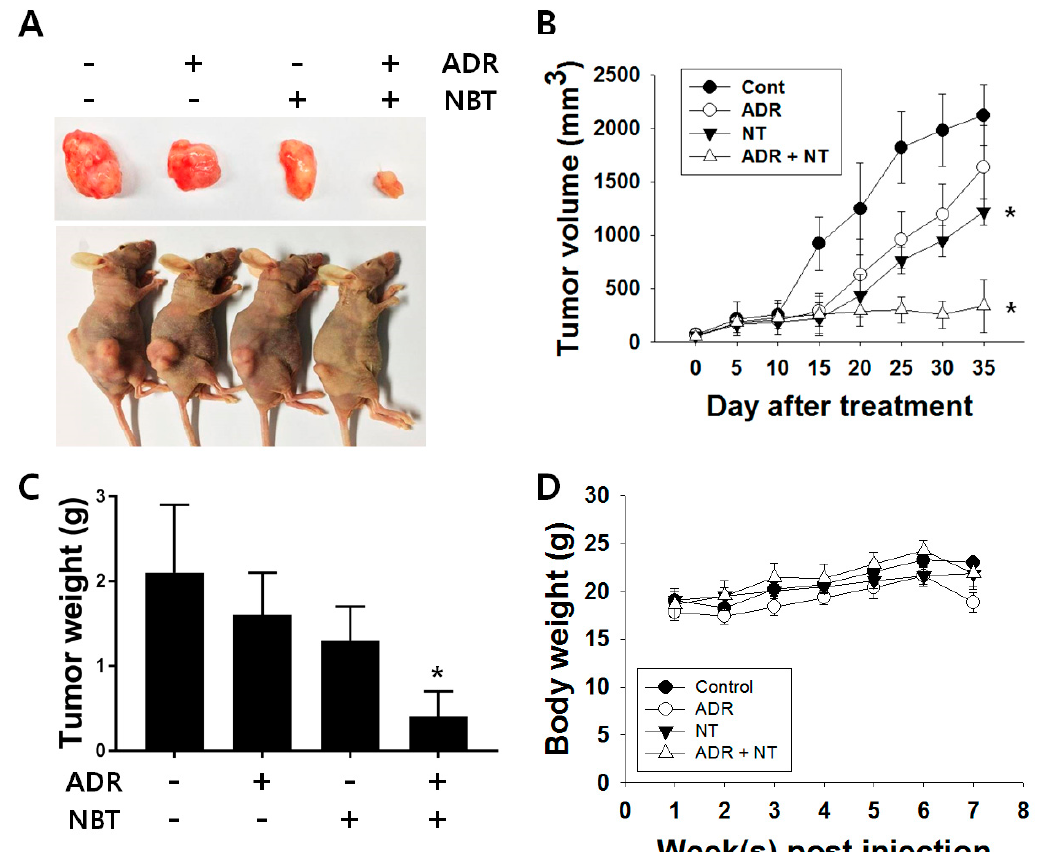
Figure 8. Antitumor effect of NBT in a nude mice xenograft tumor model. ( A ) Representative images of the tumor burden obtained from each group. ( B ) The tumor volume in each group was assessed by calipers and calculated as the length × width × width × 0.5. ( C ) Each bar represents the mean ± standard error of mean (SEM) of the tumor weight of four groups. ( D ) There were no significant changes in the body weights of the mice during the ADR and NBT treatment periods. * p < 0.05.